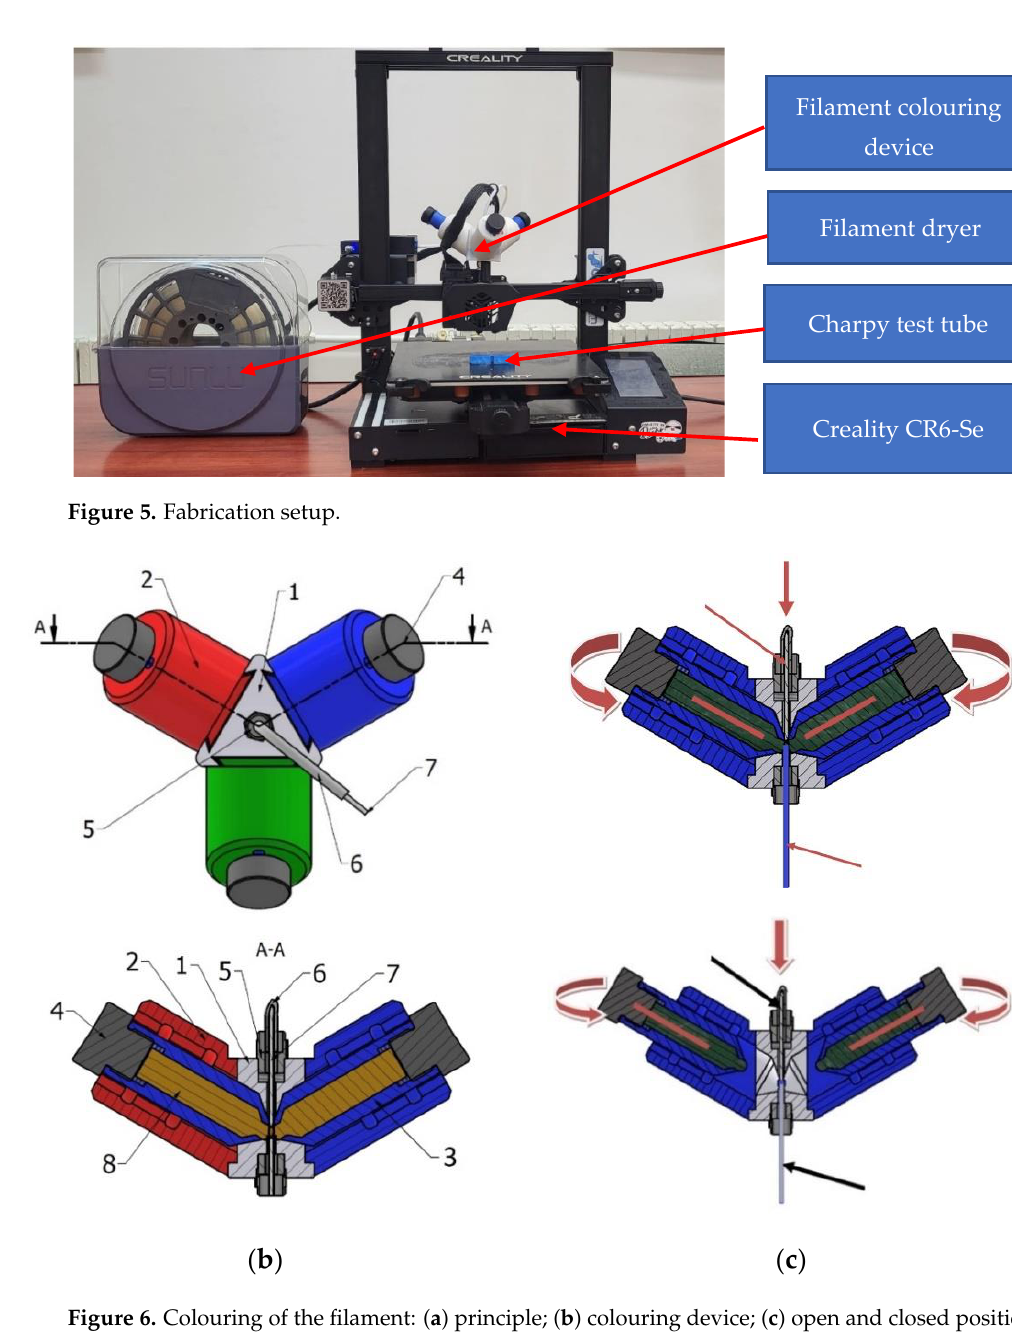
Figure 6. Colouring of the filament: ( a ) principle; ( b ) colouring device; ( c ) open and closed posi- tions.